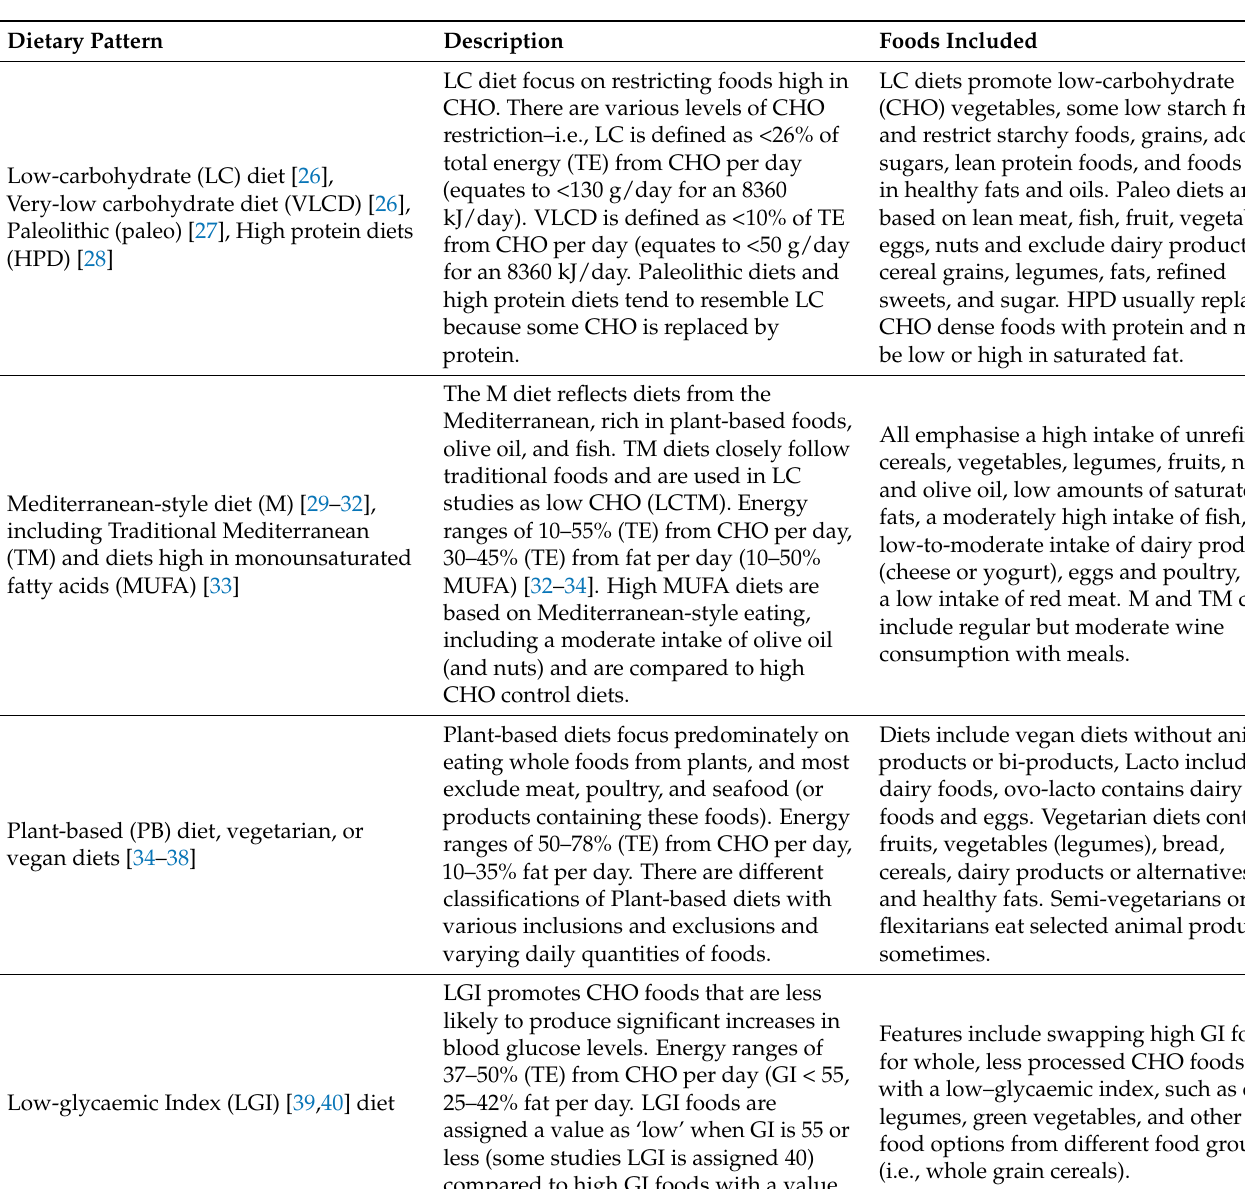
Table 1. Types of dietary patterns identified for supporting the dietary management of Type 2